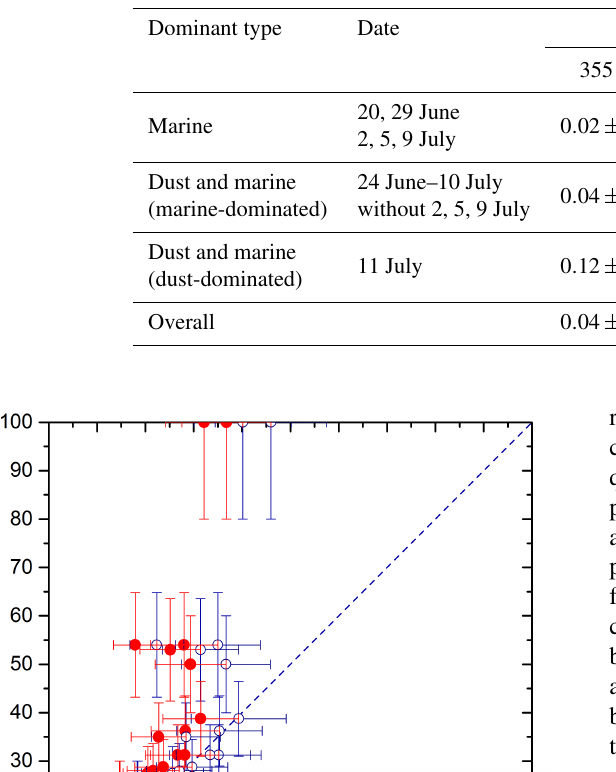
Table 1. Mean values of the lidar ratio and particle linear depolarization ratio (PLDR) including the mean systematic errors ( ± ) for different aerosol types and their dominant time periods. ∗ ± values for the overall mean values indicate the standard deviation of the mean.